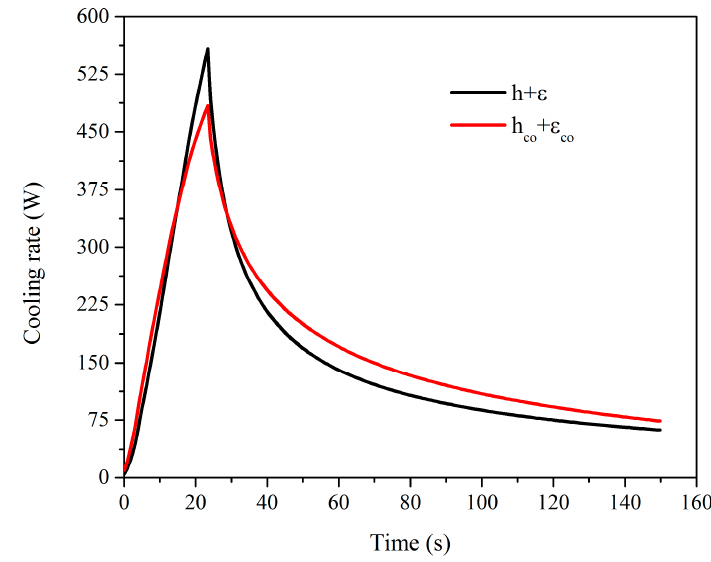
Figure 8. Overall cooling rate for t+ = 2 ms.